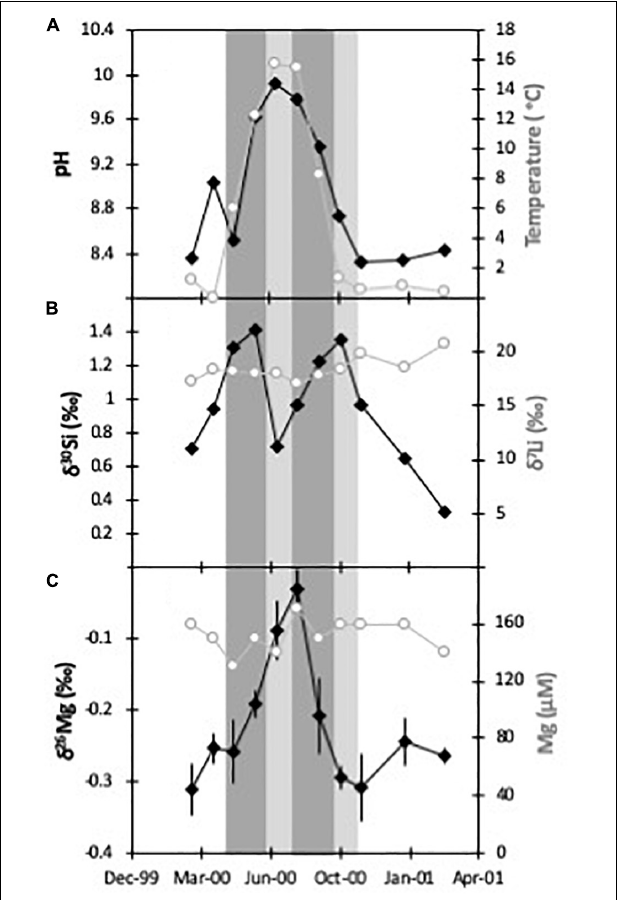
FIGURE 9 | Parameters for the Laxa River outflow time series: (A) pH and temperature; (B) Si and Li isotopes (Opfergelt et al., 2011; Pogge von Strandmann et al., 2016); (C) Mg isotopes and Mg concentrations. The error bars represent the 2sd analytical uncertainty. The dark gray bars represent the spring and autumn diatom blooms, while the light gray bars represent the ice-free